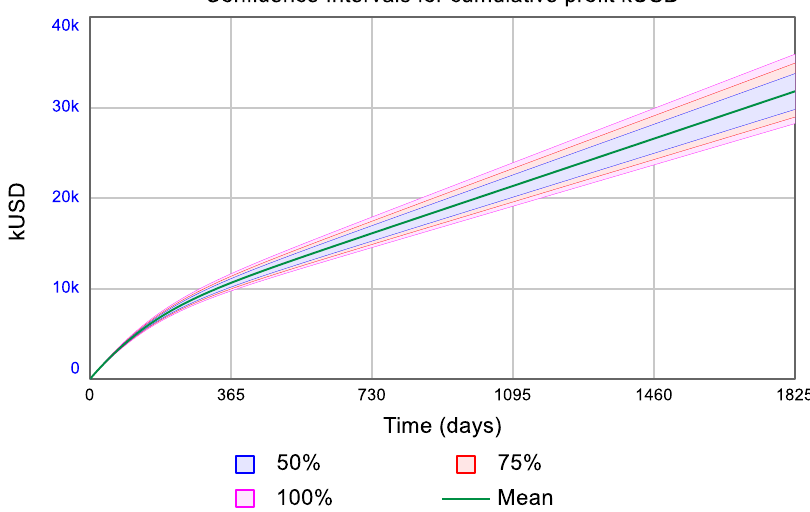
Figure 12. Cumulative profit over five years (1825 days) for different values of the decision times (repair to working, replaced to working, and maintained to working). The mean value and confidence intervals are